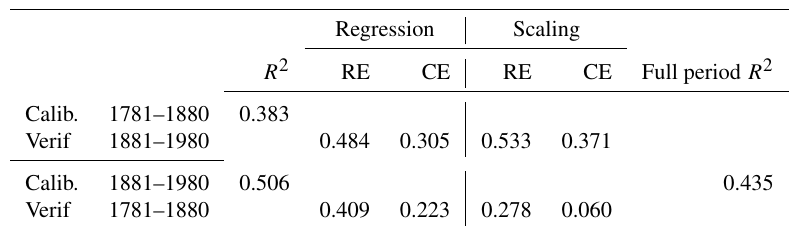
Table 3. Reconstruction statistics computed for both regressions and scaling over the inverted subperiods of calibration and verification. RE stands for reduction of error; CE stands for coefficient of efficiency.